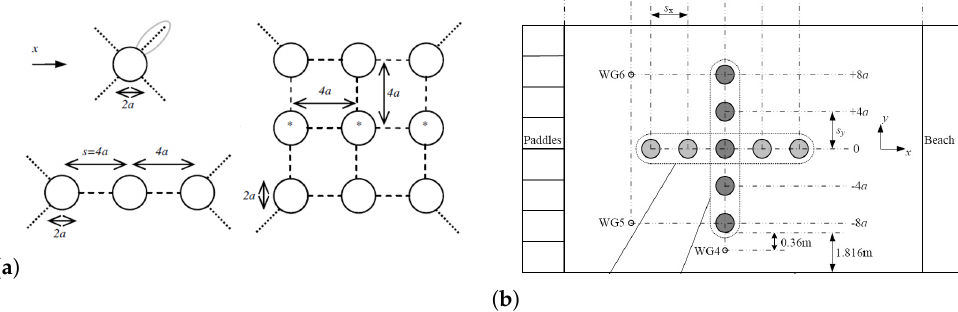
Figure 2. Wave flume of Manchester University’s WEC array layout ( a ) used by Stallard et al., adapted with permission from Ref. [30], 2008, Stallard et al. and ( b ) used by Thomas et al., adapted with permission from Ref. [31], 2008, Thomas et al.